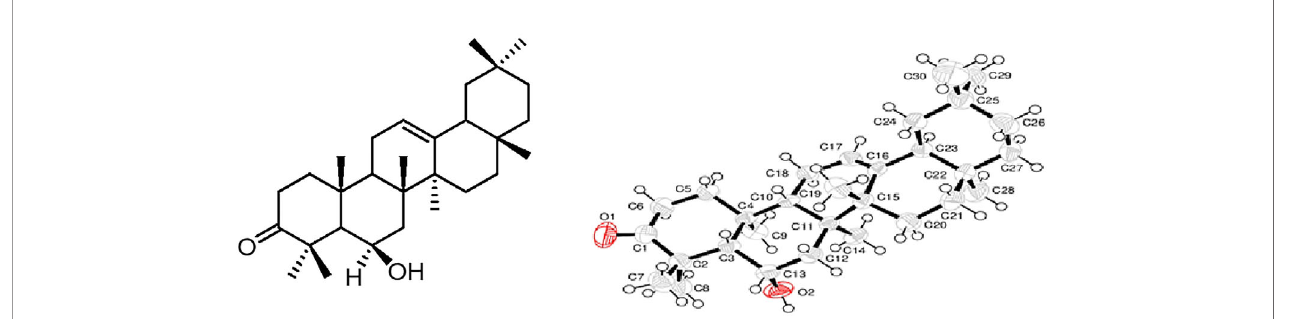
FIGURE 1 | Chemical structure and x-rays ’ crystallographic image of daturaolone ( 1 ) isolated from Datura